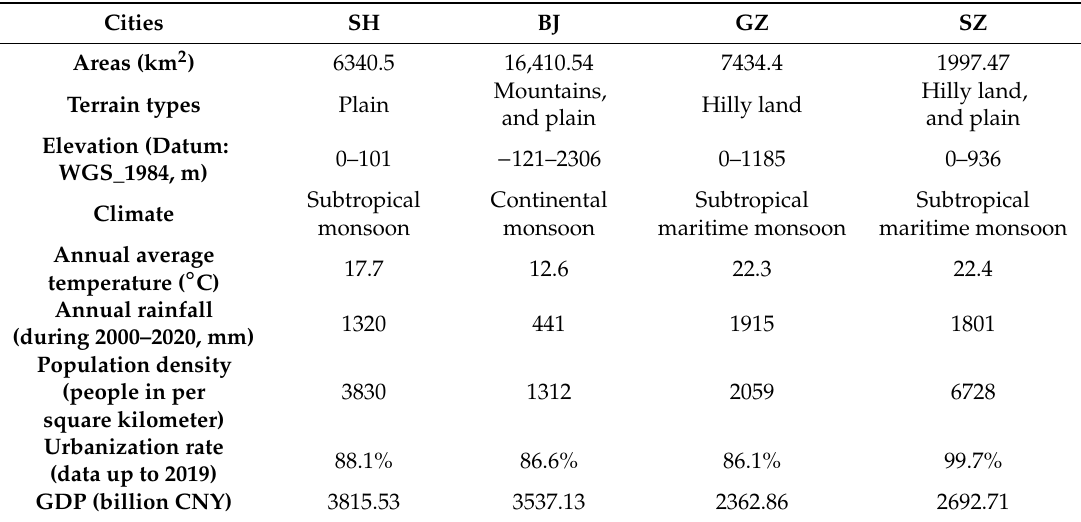
Table 1. Information about the four study